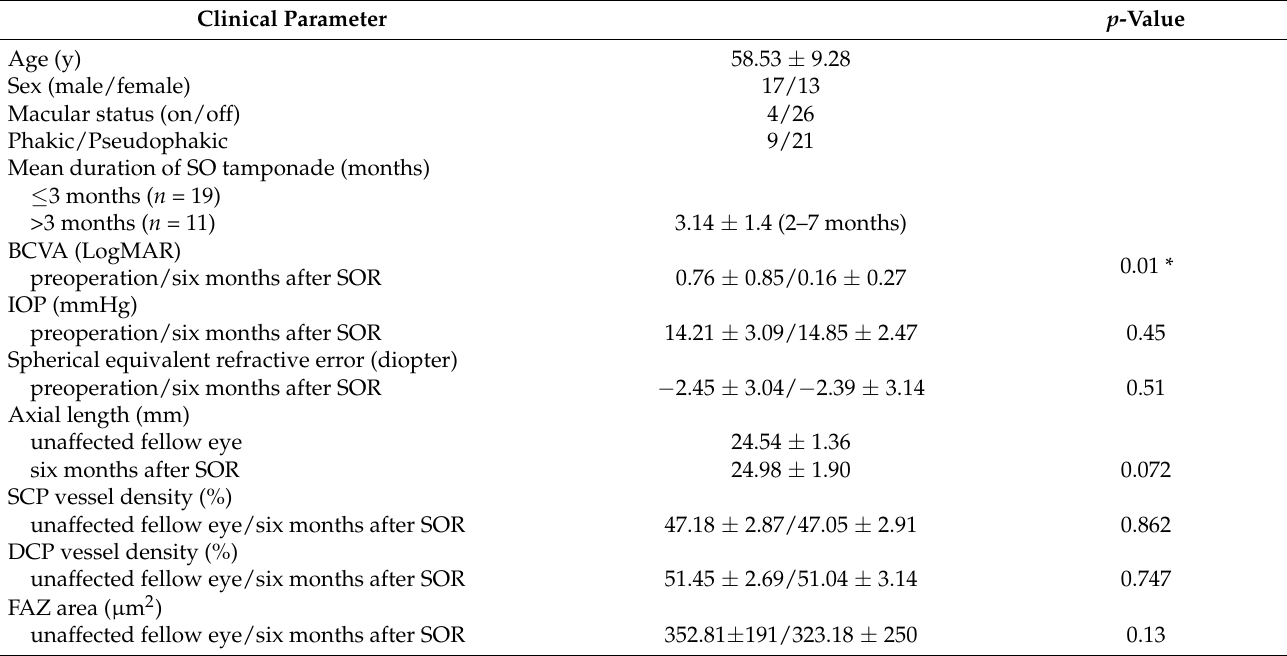
Table 1. Baseline clinical characteristics of patients undergoing vitrectomy with silicone oil tamponade due to rhegmatoge- nous retinal